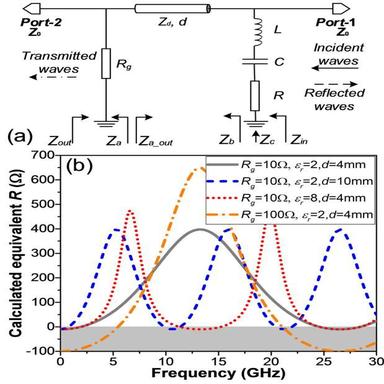
(a) The equivalent circuit model of general single-layer WMA materials. (b) Frequency dependent equivalent resistance R spectra under different Rg, εr or d.